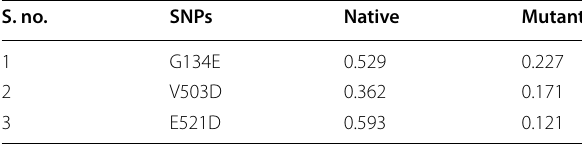
Table 7 RMSF values of potentially deleterious SNPs Table 8 Results of pathogenicity analysis using DUET web server